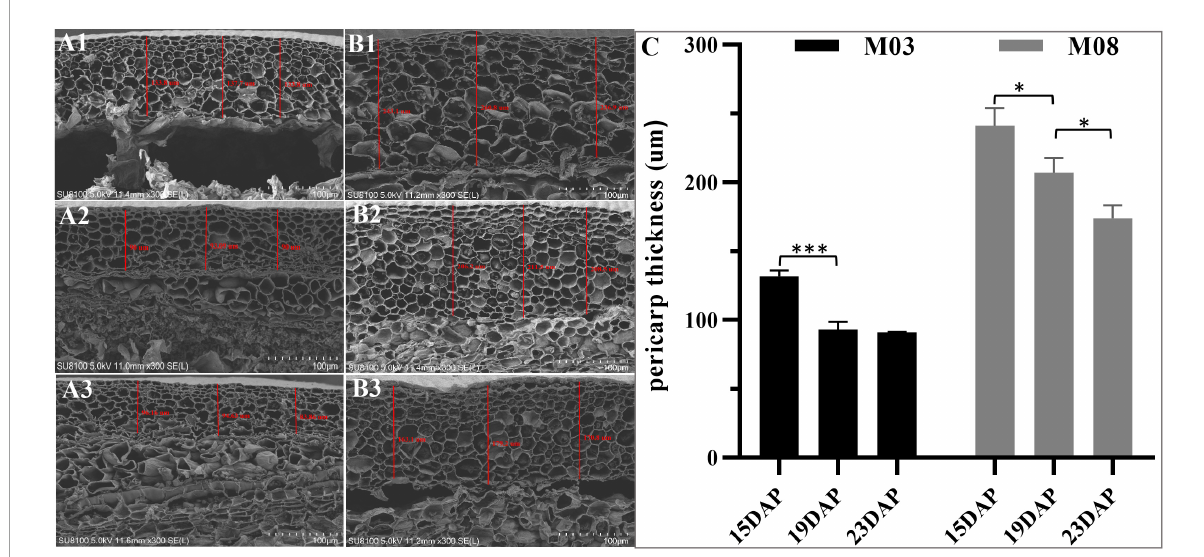
FIGURE1 SEM analyses of the changes in pericarp thickness between M03 and M08. (A) The pericarp thickness of M03 at 15 (A1) , 19 (A2) , and 23 (A3) DAP. (B) The pericarp thickness of M08 at 15 (B1) , 19 (B2) , and 23 (B3) DAP. (C) The changes in pericarp thickness in sweet corn lines M03 and M08. Asterisks indicate significant differences between M03 and M08 lines using Student’s t -test; * P < 0.05; *** P < 0.001.